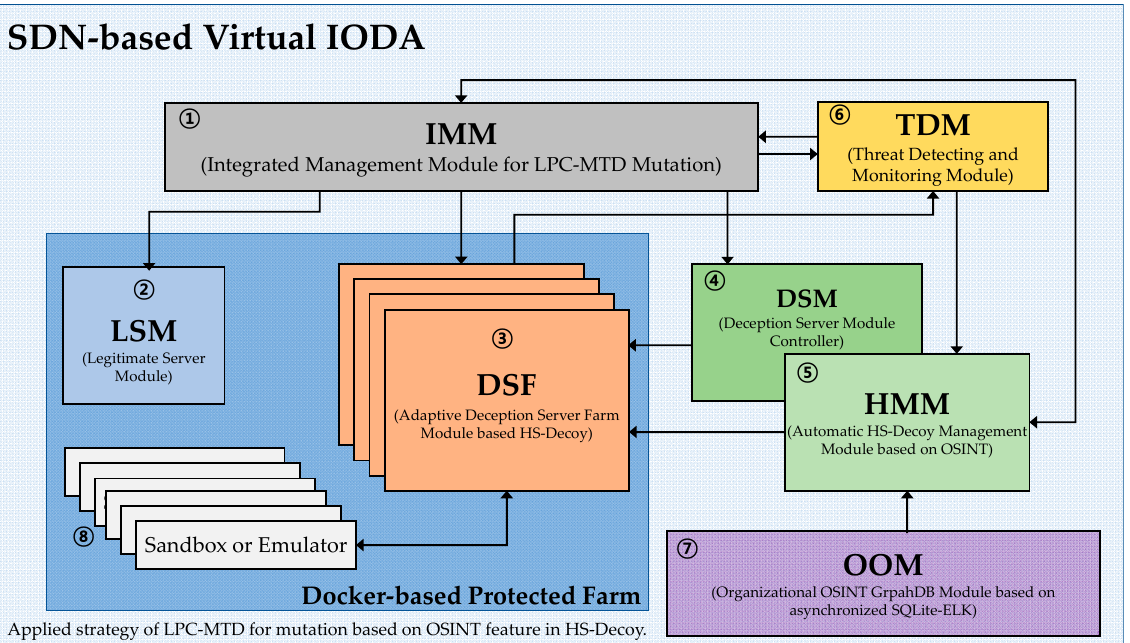
Figure 4. Overview of software defined network (SDN)-based integrated OSINT-based deceptive architecture (IODA) structure and related deceptive modules with LPC-MTD and HS-Decoy.